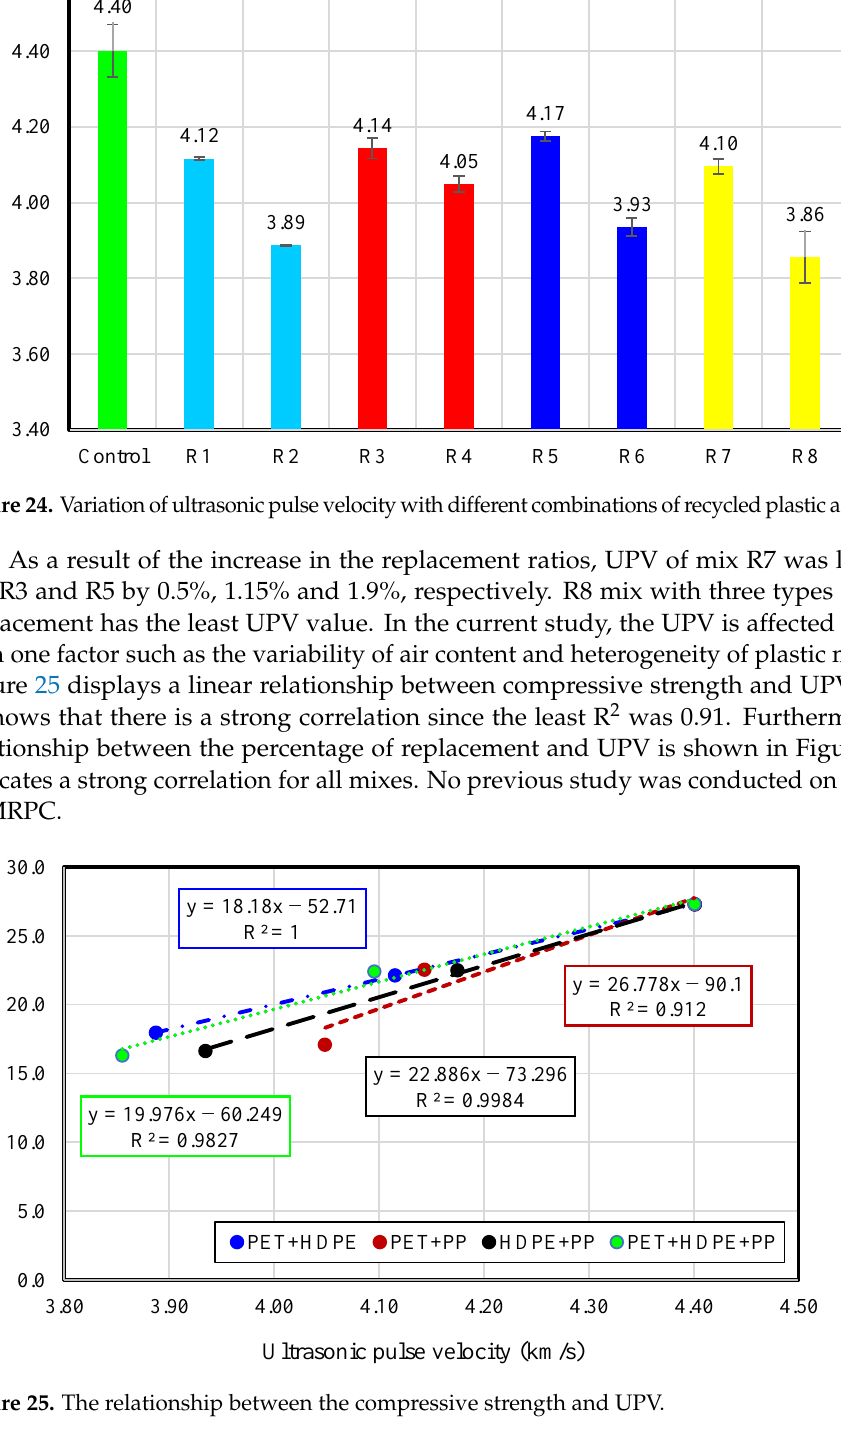
Figure 25. The relationship between the compressive strength and UPV.